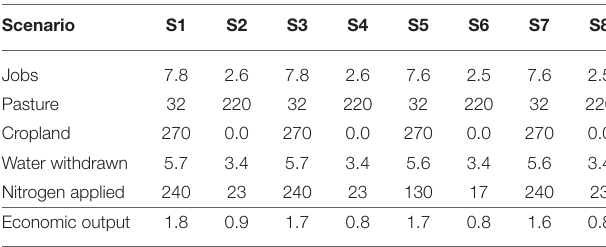
TABLE 3 | Percent increases in φ and x vector outputs relative to 2012 base